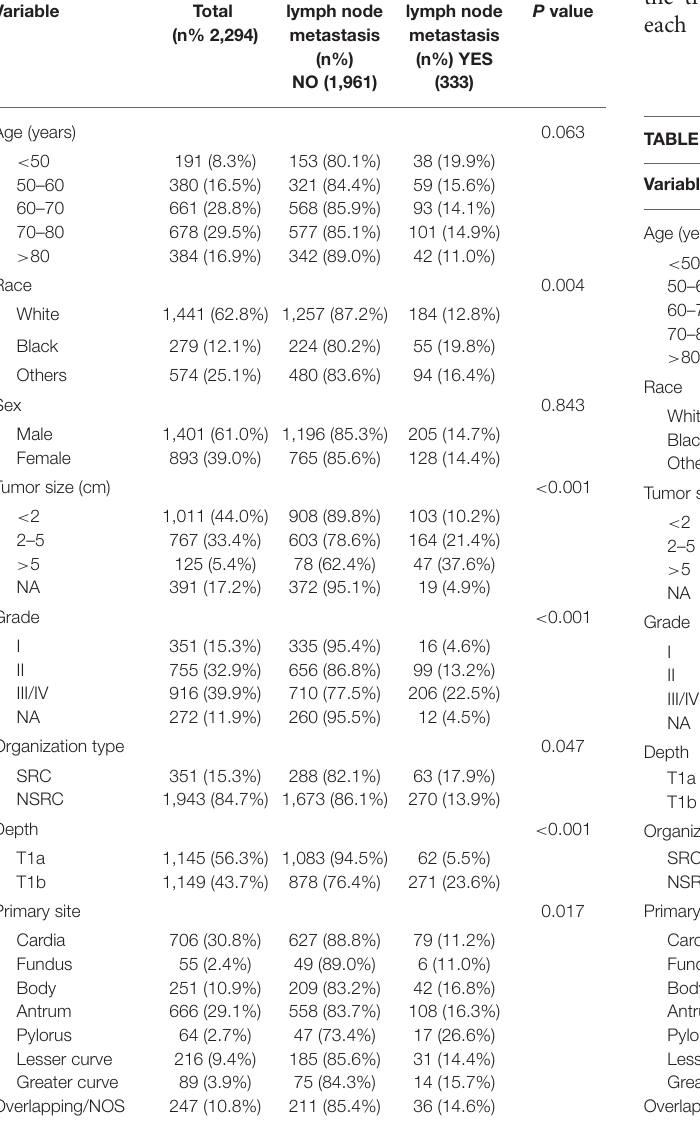
TABLE 2 | General characteristics and lymph node metastasis in the SEER